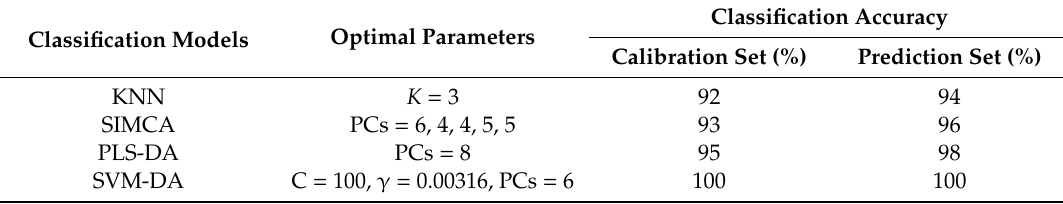
Table 2. Comparison of the classification accuracy of the K -nearest neighbor (KNN), soft independent modeling of class analogy (SIMCA), partial least squares-discriminant analysis (PLS-DA), and support vector machine-discriminant analysis (SVM-DA) models.